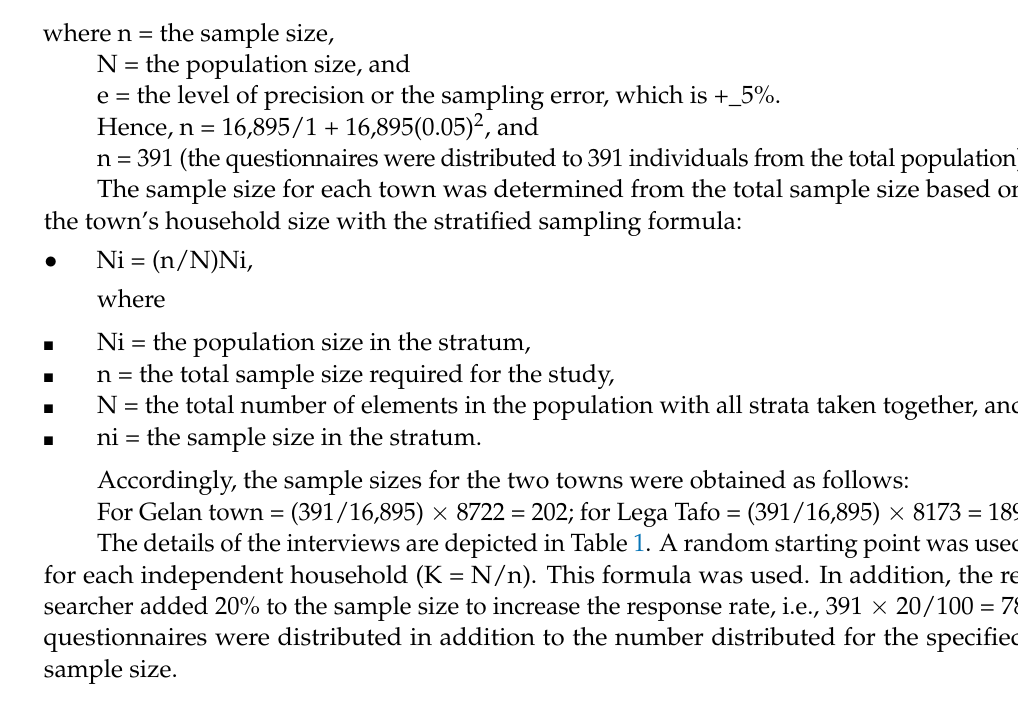
Table 1. The summary of interviews conducted with the key informant